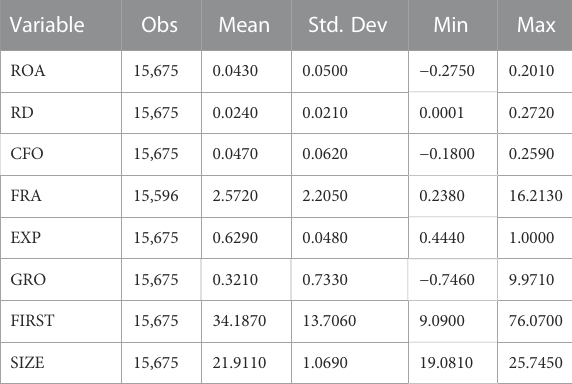
TABLE 2 Descriptive